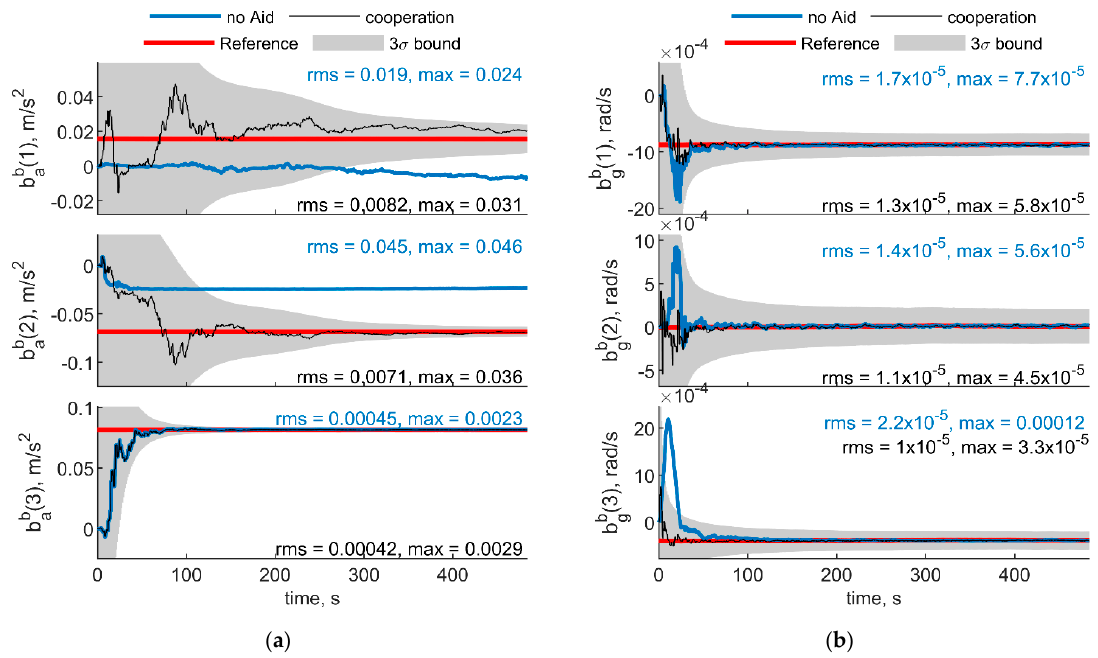
Figure 19. ( a) Accelerometer and ( b ) gyroscope biases predicted by the filter. One deputy. Chief flies along the trajectory depicted in Figure 3 and deputy is steady at [ − 100 m, − 20 m, − 20 m] T in NED coordinates. Reference value is reported in red. Results obtained with cooperation and without cooperation have been reported in black and blue, respectively. RMS and maximum error value have been evaluated starting from t = 60 s.